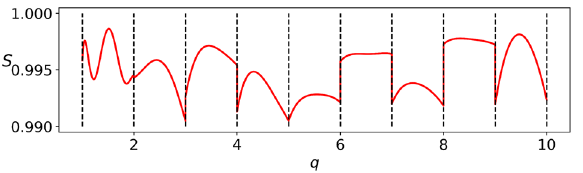
Figure 5. Overlap S ( q ) for the symbolic waveforms vs the mass ratio q , when compared to ground truth solutions, using q ∼ 10 6 values. The minimum and maximum overlaps are S = 0.9905 and S = 0.9986 , respectively. The dotted lines delimit each subdomain [ q i , q i + 1 ] for i = 1 . . . 9 .